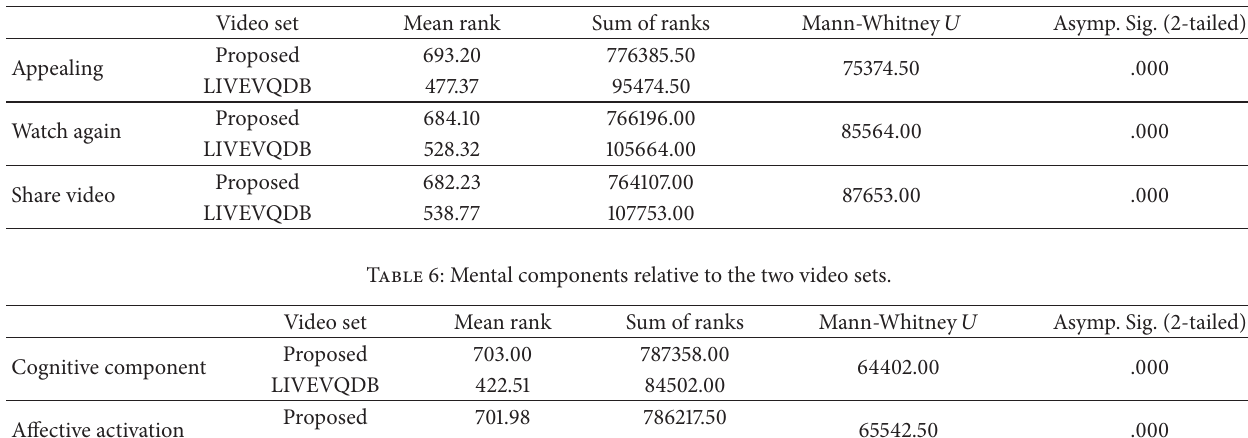
Table 5: Comparison of conative dimensions by the two sets.